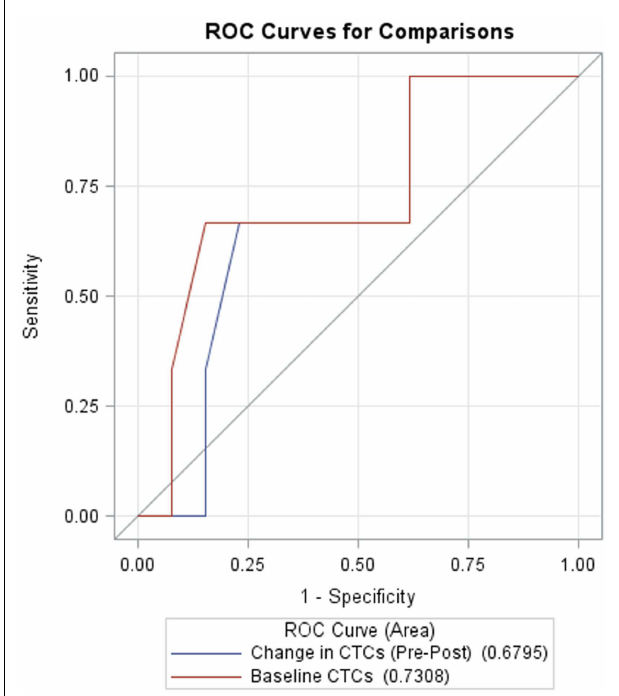
FIGURE 4 | Receiver operating characteristic (ROC) curves for CTCs at baseline (red,AUC = 0.7308, 95% CI: 0.36, 1.0) and change in CTCs from pre- to post-treatment (blue,AUC = 0.6795, 95% CI: 0.33, 1.0)